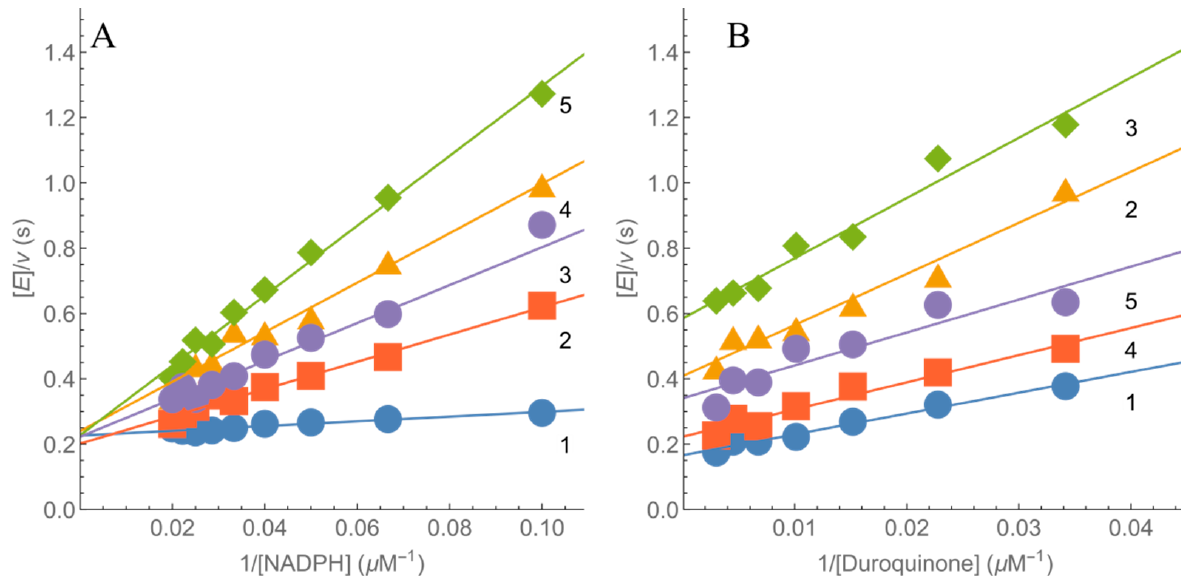
Figure 3. Inhibition of the duroquinone reductase reaction of nNOS by NADP + and 2 ′ ,5 ′ -ADP. ( A ) Inhibition at varied NADPH concentrations in the presence of 250 µM duroquinone : 1—inhibitor is absent, 2—200 µM NADP + , 3—400 µM NADP + , 4—50 µM 2 ′ ,5 ′ -ADP, 5—100 µM 2 ′ ,5 ′ -ADP. ( B ) Inhibition at varied concentrations of duroquinone in the presence of 50 µM NADPH: 1—inhibitor is absent, 2—1.0 mM NADP + , 3—2.0 mM NADP + , 4—250 µM 2 ′ ,5 ′ -ADP, 5—500 µM 2 ′ ,5 ′ -ADP. [E] is the enzyme concentration (M), and v is reaction rate (Ms − 1 ).